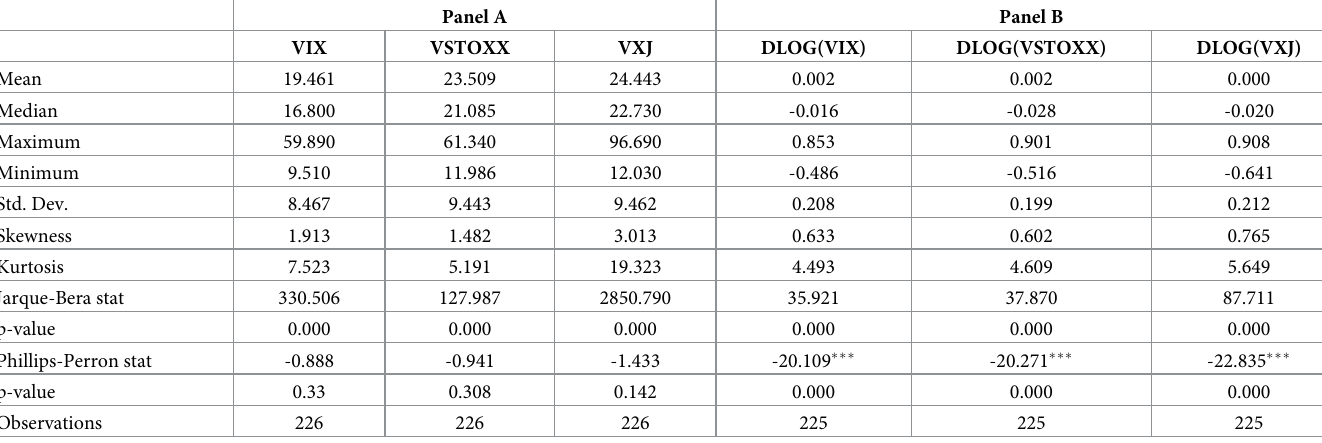
A simple transformation of the matrix of linear correlation between return assets into an equivalent distance produces a connected network studied in numerous works. In this net- work, the nodes correspond to the assets, and the edges that join them represent the distances obtained from those correlations. All the nodes are connected with them, so if the network has N nodes, there will be N(N—1)/2 edges. Table 2. Summary statistics of monthly implied volatility